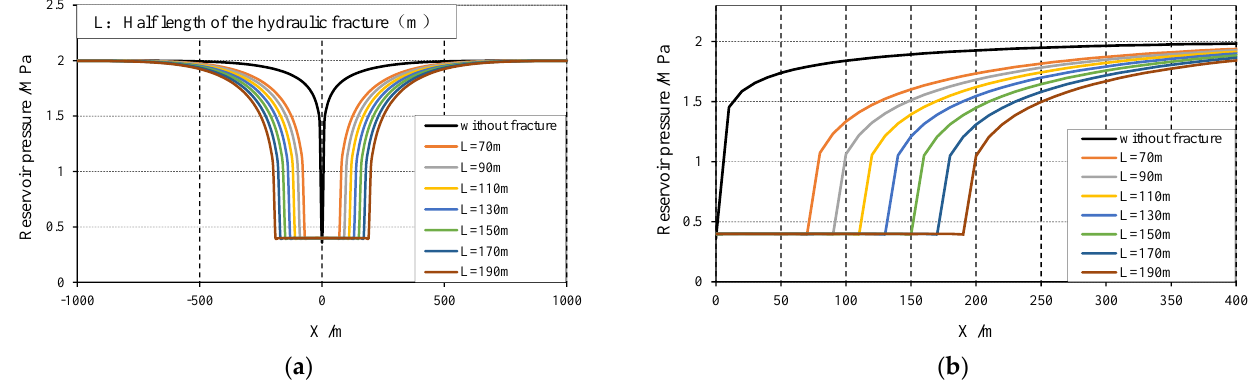
Figure 12. The reservoir pressure when different fracture lengths of each point on profile line 2 after mining for 5 years. ( a ) the whole profile line, and ( b ) a part of profile line 2. The CBM concentrations for different hydraulic fracture lengths are also calculated, and those on profile lines 1 and 2 (see Figure 5) after 5 years of extraction are shown in Figure 13. When there is a hydraulic fracture, the CBM extraction volume is much larger than that without a hydraulic fracture. Figure 14 shows the average CBM production rate and CBM recovery rate of the reservoir with different fracture morphologies. With the the average daily gas production at the same time of extraction also increases gradually.